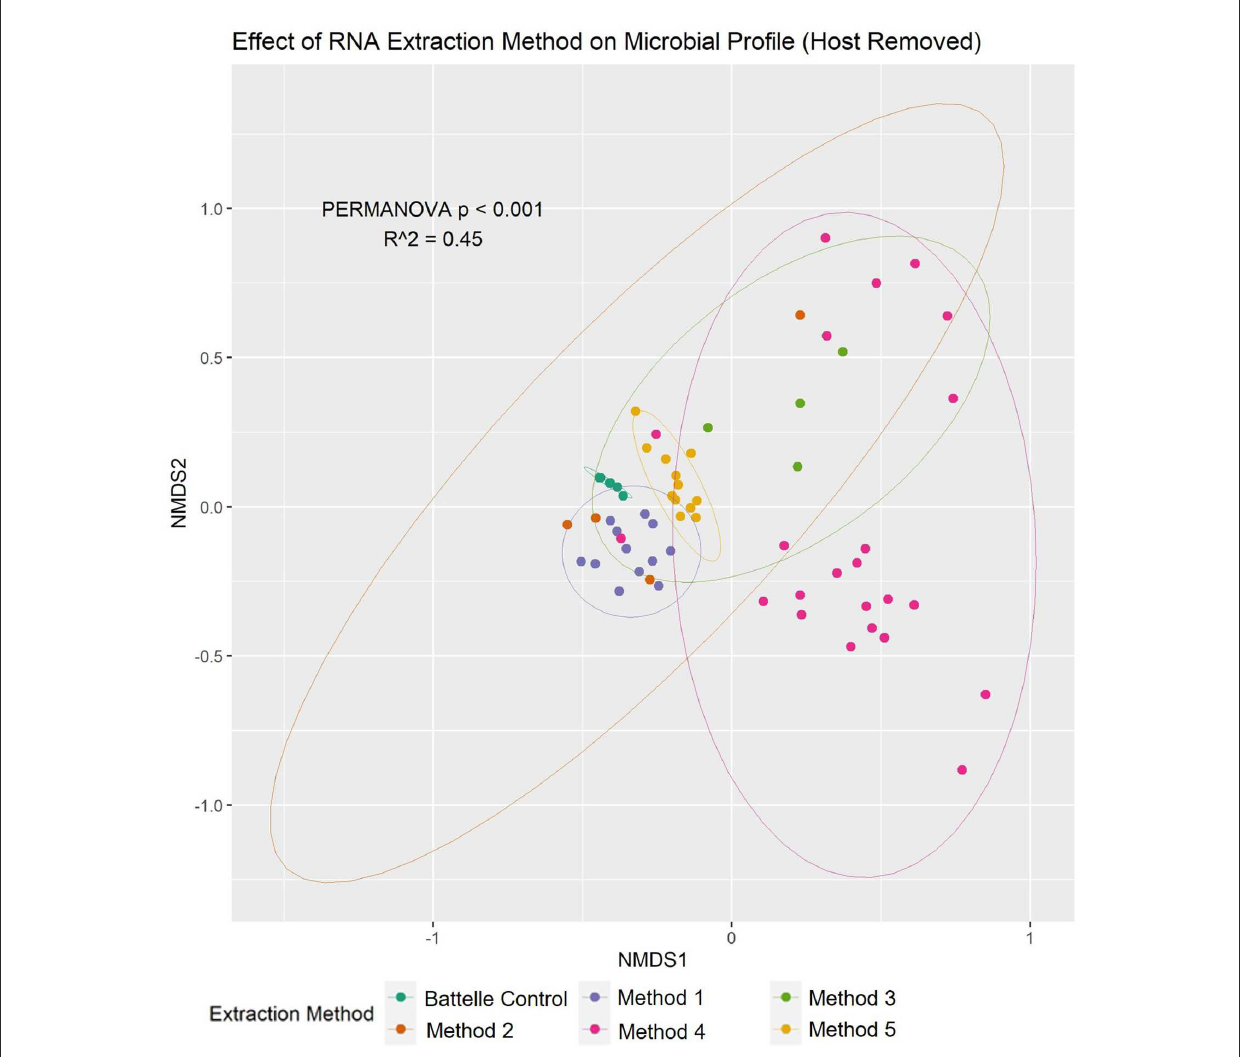
FIGURE3 Nucleic acid extraction method had a significant effect on the wastewater microbiome profile based on NMDS and multivariate statistics. Non-metric multidimensional ordination plot showed that there was significant (PERMANOVA p < 0.001) difference between the microbiota composition of samples based on the method used to extract the RNA (shown in different colors). 95% confidence intervals for each method are also shown in the